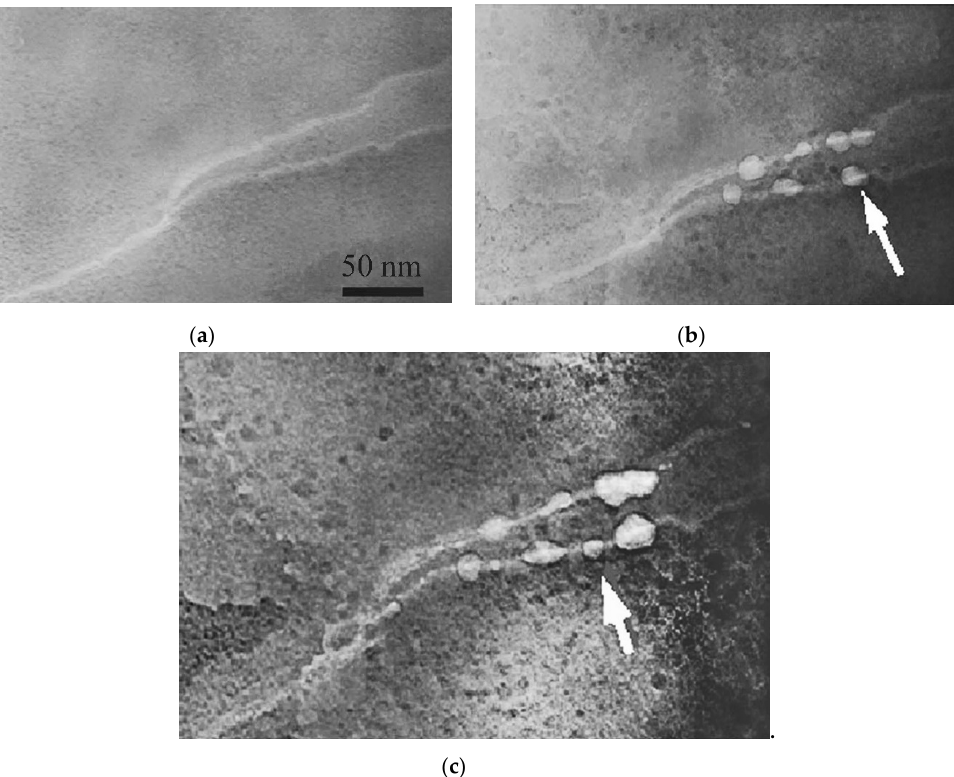
Figure 13. Shear bands in amorphous Al 88 Ni 2 Y 10 after deformation at room temperature ( a ), nanopores (marked with arrows) in shear bands after ageing at room temperature for 1.78 × 10 7 s ( b ), nanopores in shear bands after ageing at RT for 2.96 × 10 7 s ( c ) [reproduced from Mechanics of Materials, 2017, 113, 19 with permission from Elsevier, 2020] [86].